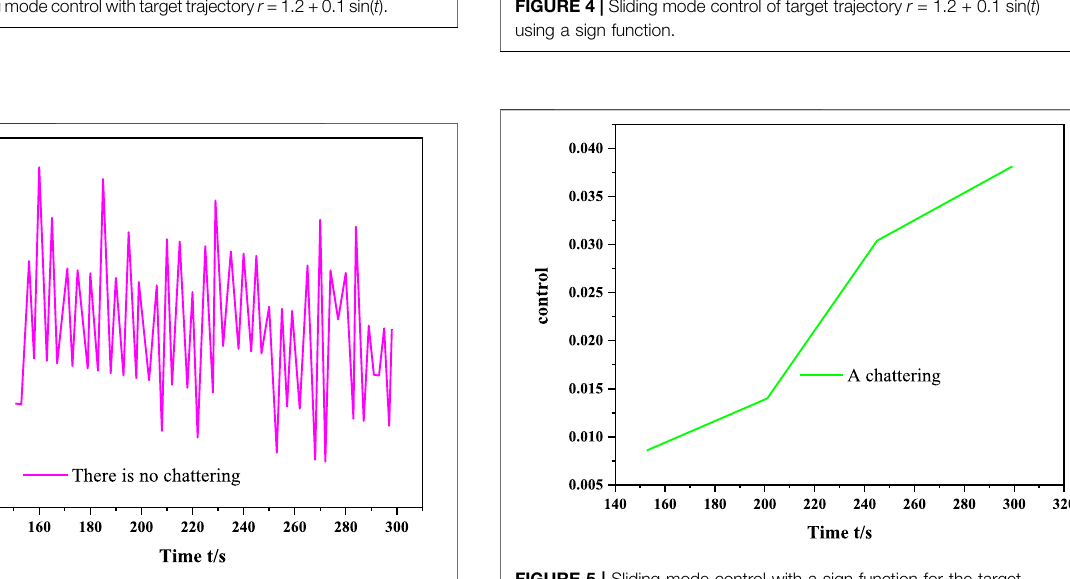
FIGURE 5 | Sliding mode control with a sign function for the target trajectory r =